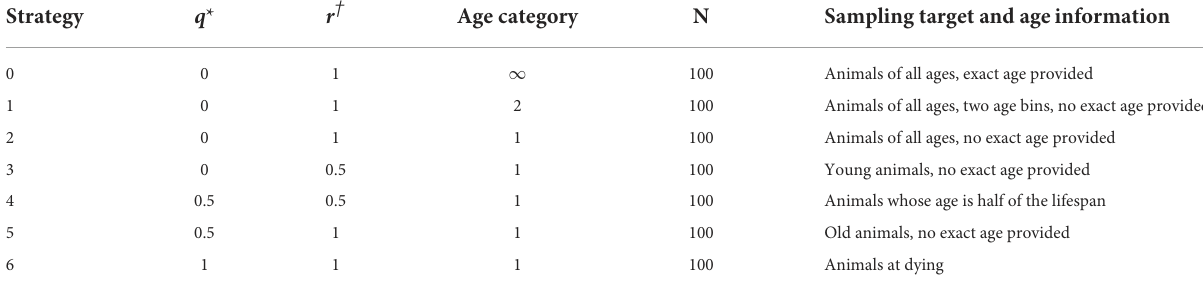
TABLE 1 Seven sampling strategy models. Strategy Age category N Sampling target and age information